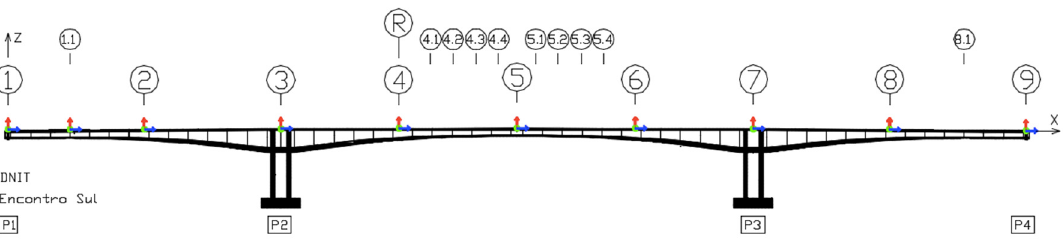
Figure 16. Configuration of the measurement sections used to perform ambient vibration tests.